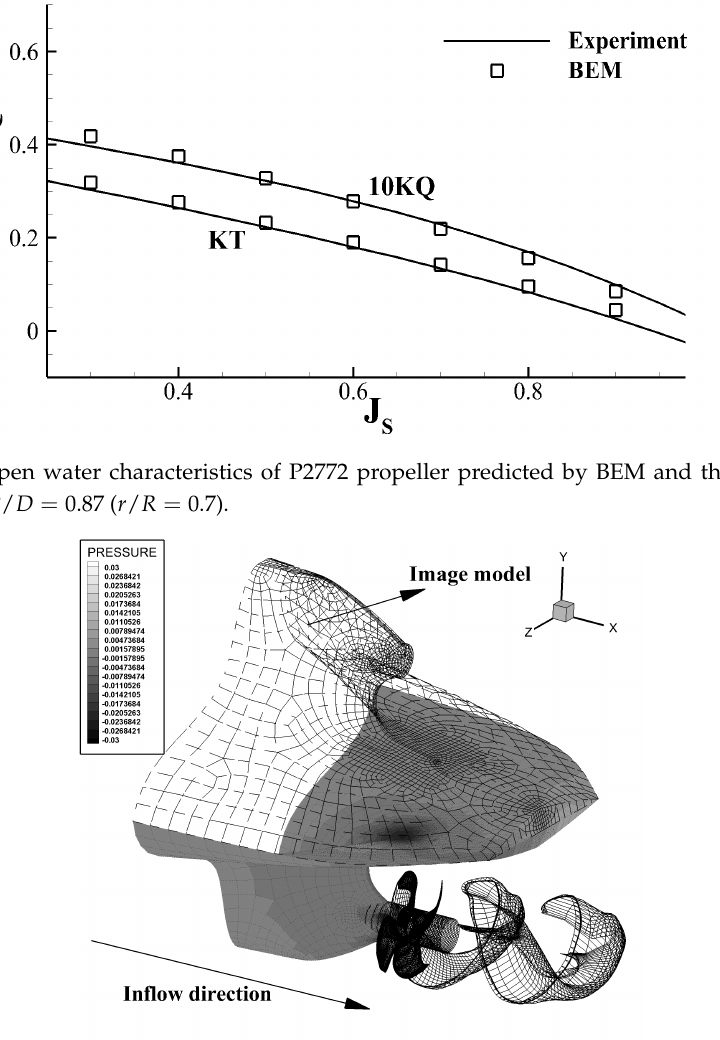
Figure 27. Pressure-BEM model without rudder geometry. Contour plot represents the dimensionless propeller-induced hull pressures ( P / ρ n 2 D 2 ) at time step t = 0. The fore part of the hull is neglected for the sake of the efficient computation. The panels on the image model are not shown for